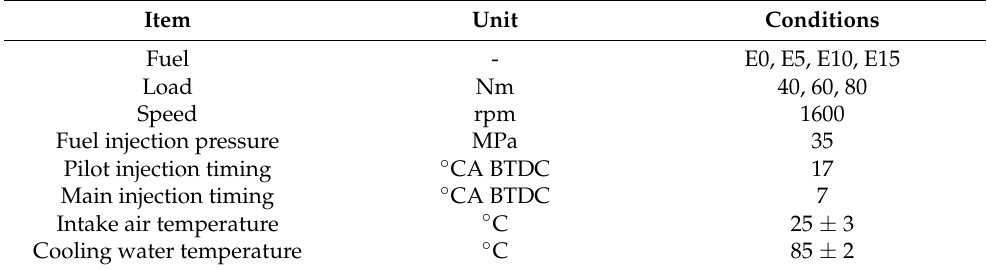
Table 3. Experimental conditions.